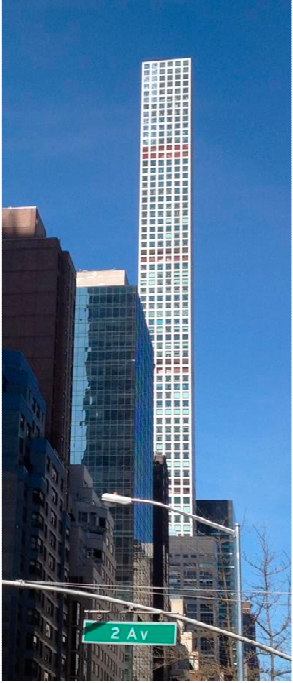
Figure 5. 432 Park Avenue in New York (photograph by Kyoung Sun Moon).